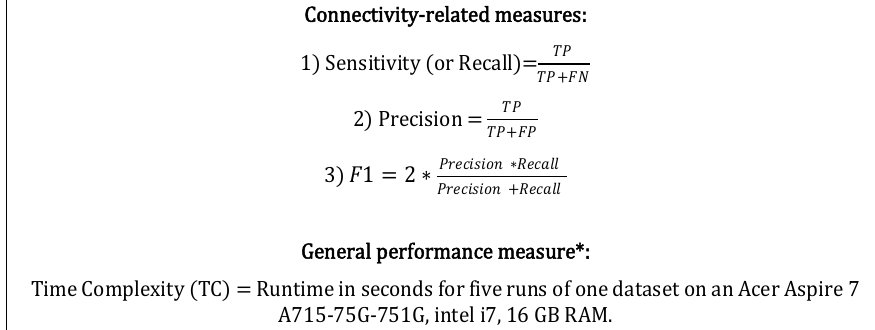
Figure 6. Main evaluation measures.